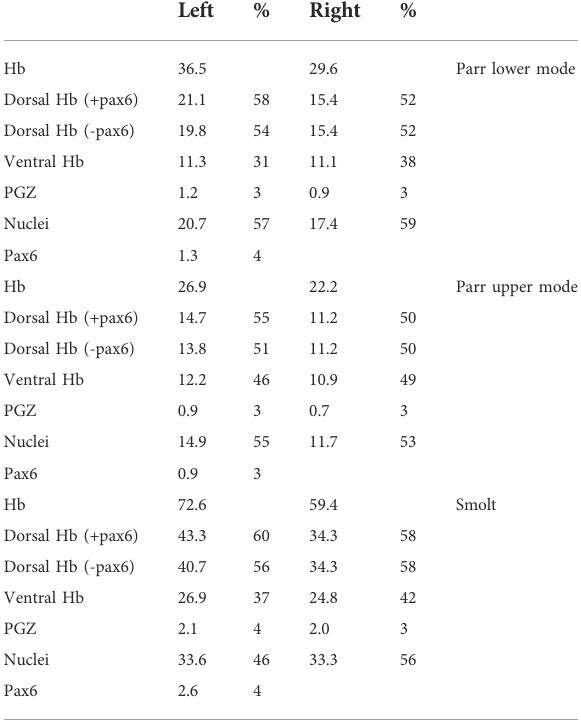
TABLE 1 Quanti fi cation of habenula subdomain volumes in Atlantic salmon. Volumes were quanti fi ed using habenula 3D reconstructions for one parr lower mode, one par upper mode and one smolt as indicated. They are indicated for the following subdomainsoftheleftandrighthabenulae(Hb)(columns2 – 3and 4 – 5 respectively): dorsal territory including the pax6 left